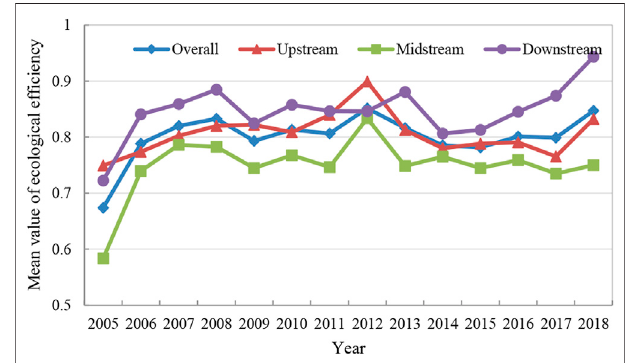
FIGURE 1 | Mean variation of eco-ef fi ciency in the Yellow River Basin from 2005 to 2018.